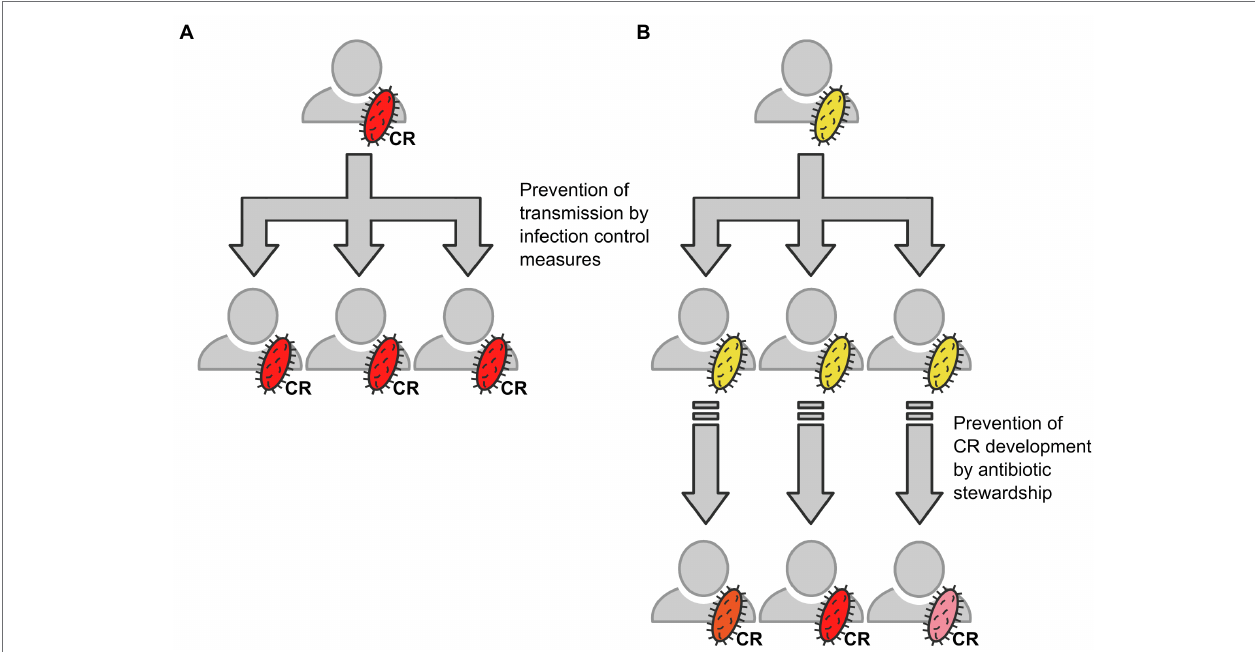
FIGURE 6 | Schematic draft of the herein described ways resulting in acquisition of CR bacteria and the respective countermeasures. (A) Direct transmission of CRGN bacteria (schematically depicted in red), for example, from patient to patient via shortcomings in infection control. (B) Transmission of a carbapenem-sensitive ancestor bacterium (schematically depicted in yellow) and subsequent individual development of carbapenem resistance (schematically depicted by different red color shapes) under antimicrobial pressure, for example, via inappropriate antimicrobial